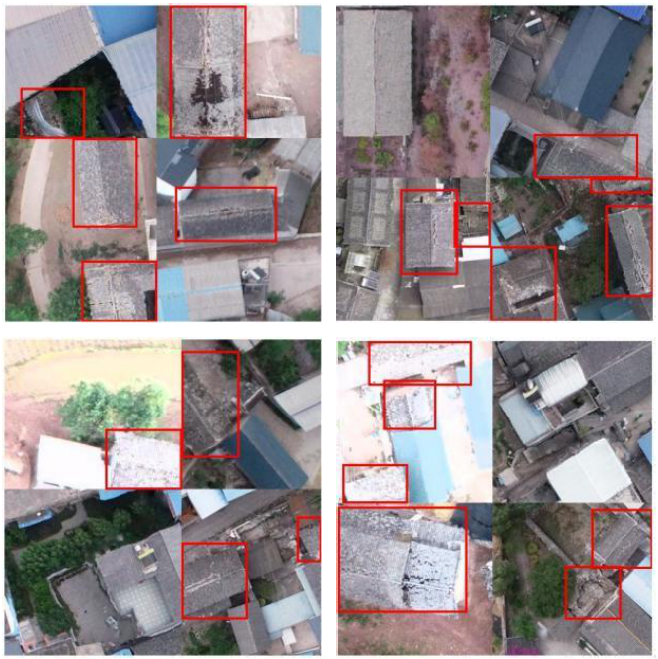
Figure 7. Examples of Mosaic data enhancement. Mosaic scales the four different images and arranges them to fit in the desired output size. The red boxes are the bounding boxes for damaged houses.